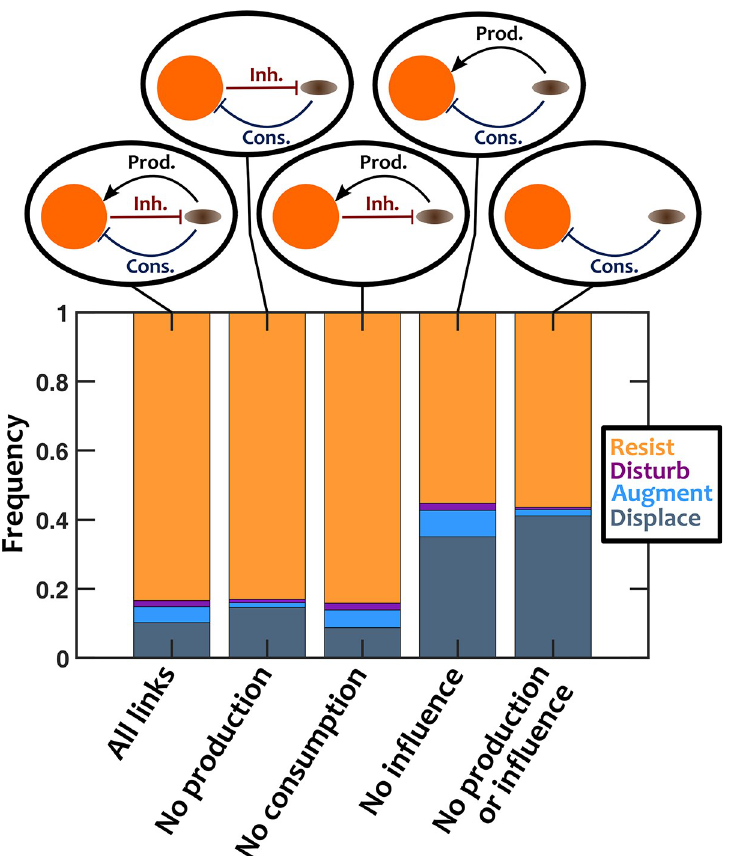
Fig 5. The effective interaction between the resident community and the invader alters the outcome of invasion. We examined how invasion outcomes changed when the interactions between the invader and resident members were altered. In the original case, the invader is inhibited by resident species, and the invader consumes and produces some chemical mediators. In other cases, the invader inhibition, consumption, or production (or a combination of them) are removed from the system, as shown in the insets, to assess the impact of each. Interactions among resident species are equally likely to be facilitative or inhibitory ( f fac = 0.5). The influence of residents on the invader is mostly inhibitory 0.1). Invader has a normalized basal growth rate of 1.5. Number of instances examined N s = 10000. ( f fac , inv =